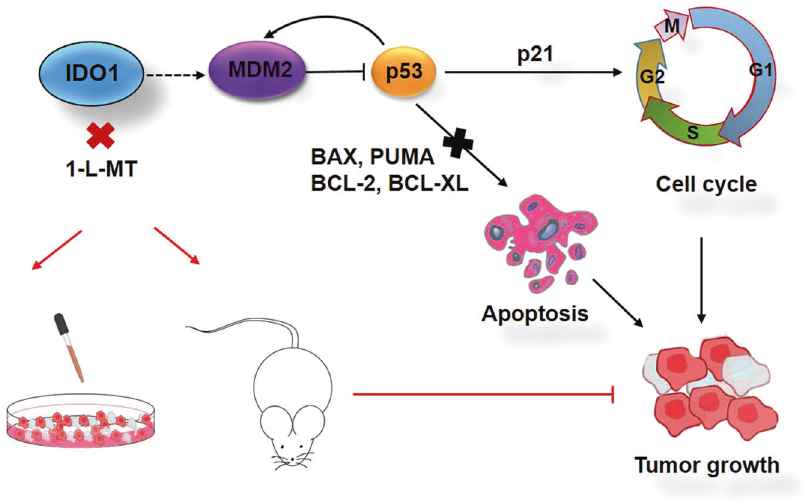
Fig. 7 A model depicts the role of the IDO1-MDM2-p53 pathway in DLBCL growth. MDM2 and p53 act downstream of IDO1 to regulate tumor cell growth. This illustrates that IDO1 inhibition could activate the p53 pathway and induce cell cycle arrest and apoptosis by downregulating MDM2 expression in DLBCL